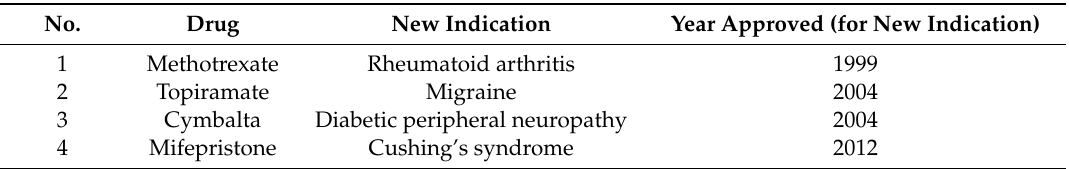
Table 1. Drug repurposing technology applications in clinical